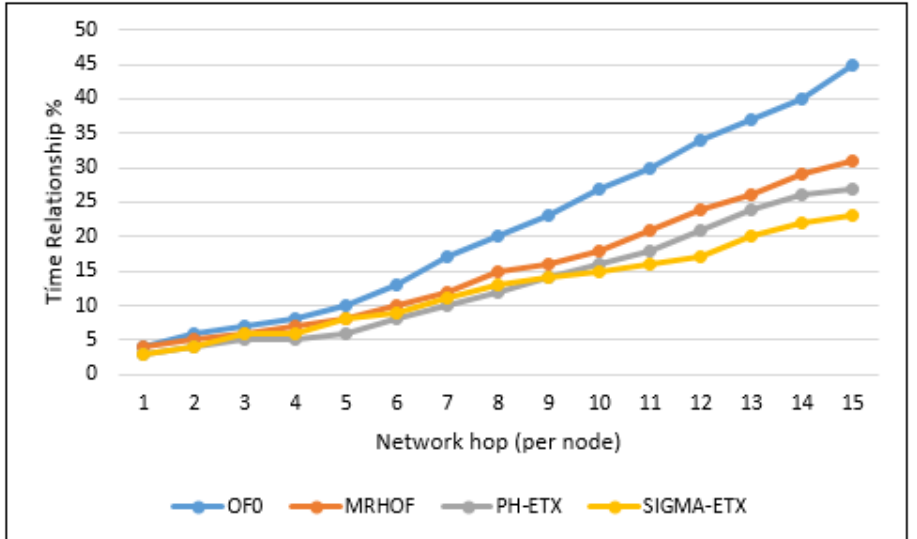
Figure 15. Energy consumption .